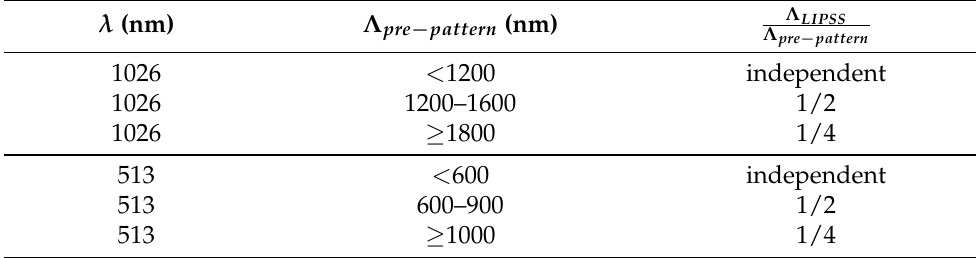
Table 1. The final period of LIPSS as a function of the laser wavelength and the pre-pattern spacing. Final period remains unaffected on the surface topography when the pre-existing period is compara- ble to the laser wavelength. This table is valid when the laser polarisation is perpendicular to the pre-pattern period